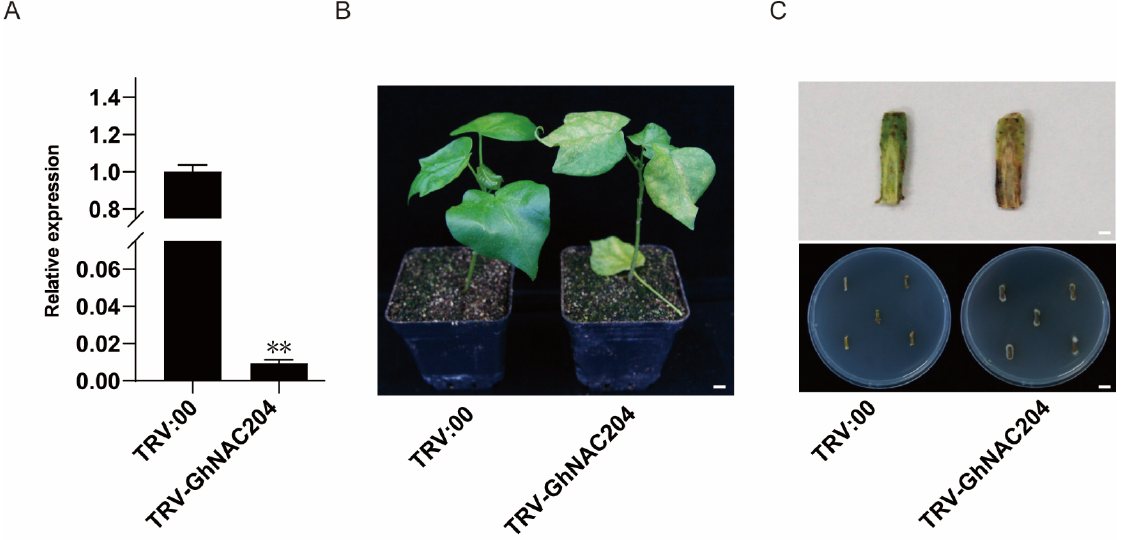
Figure 6. GhNAC204 could be a positive regulator in cotton resistance to V. dahliae infection. ( A ) Detection of GhNAC204 silencing efficiency by qRT-PCR. GhUBQ7 was used as an internal reference gene and data are means ± SD from three biological replicates; asterisks indicate significant differences when compared with TRV:00 ( p < 0.05). ( B ) Silencing of GhNAC204 leads to severe disease symptoms including leaf chlorosis and wilting; bar = 3.5 cm. ( C ) Silencing of GhNAC204 leads to more numbers of fungal colonies in stem segments compared with TRV:00 ; upper panel, stem inspection vascular discoloration, bar = 0.3 cm; bottom panel, recovery assay, bar = 2 cm. Photos were taken at 28 days after V. dahliae inoculation (40 days after VIGS).